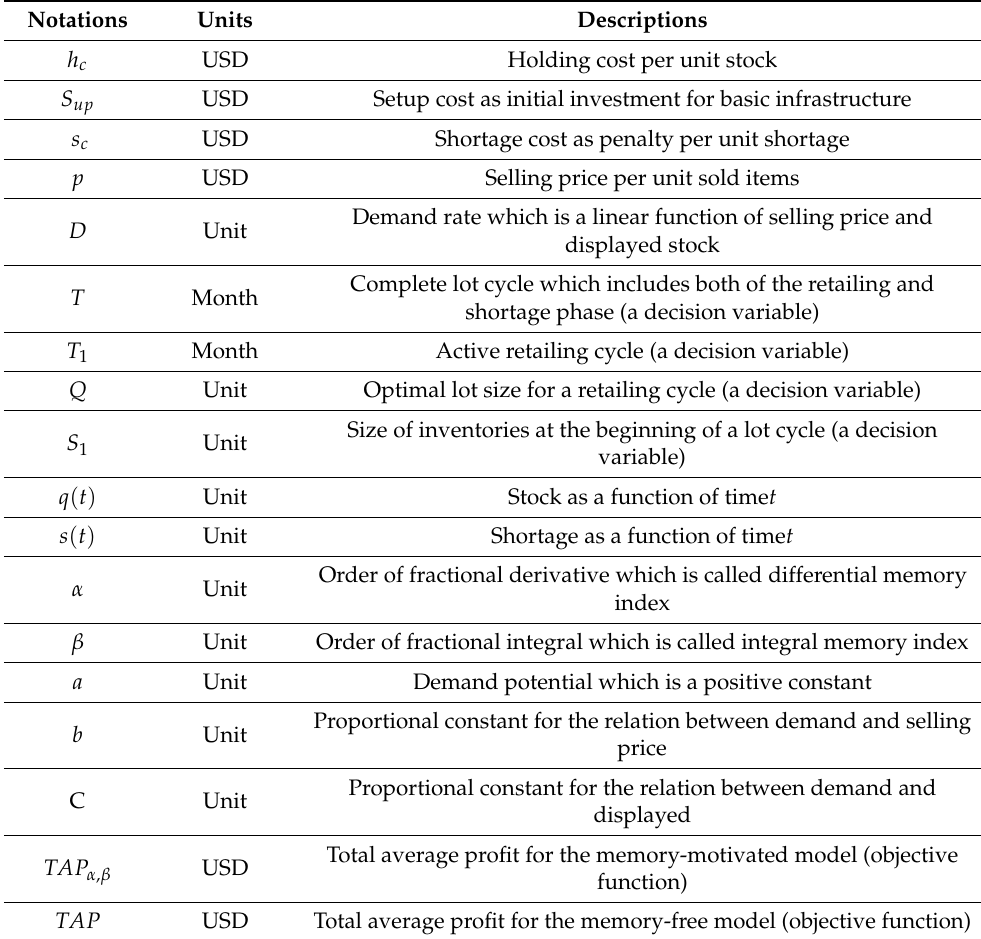
Table 2. Symbols and notations with their units and meanings which are representing the objective functions, decision variables, different costs and revenues and coefficients in this